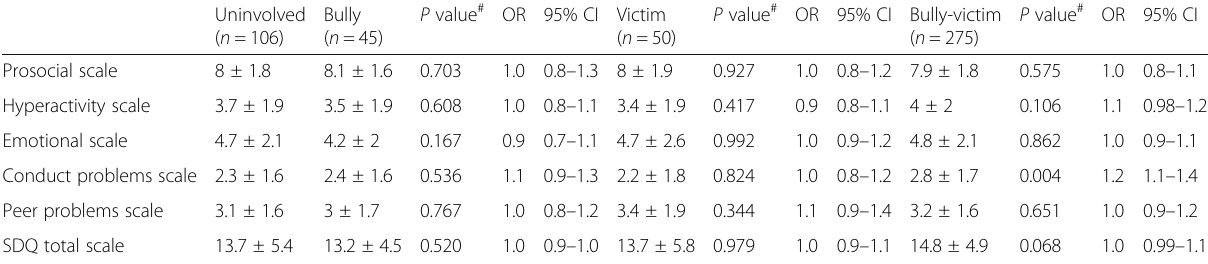
Table 5 Association between bullying subgroups and behavioral disorders as per the Strengths and Difficulties Questionnaire among